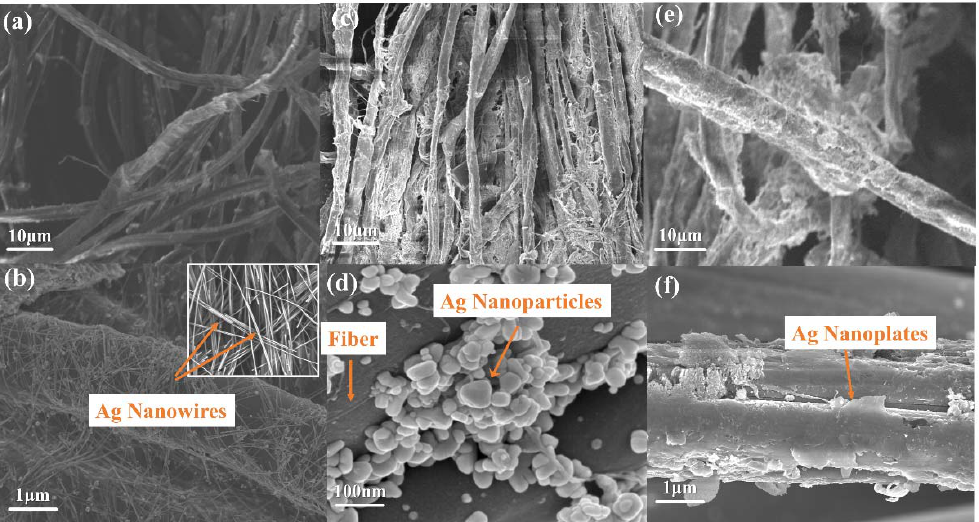
Figure 5. ( a , b ) SEM image of conductive fabric fiber prepared by dip-coating process. ( c , d ) SEM images of natural cotton and linen fabric fibers processed by in situ growth process. ( e , f ) SEM images of conductive fabric fibers prepared by in situ growth process.